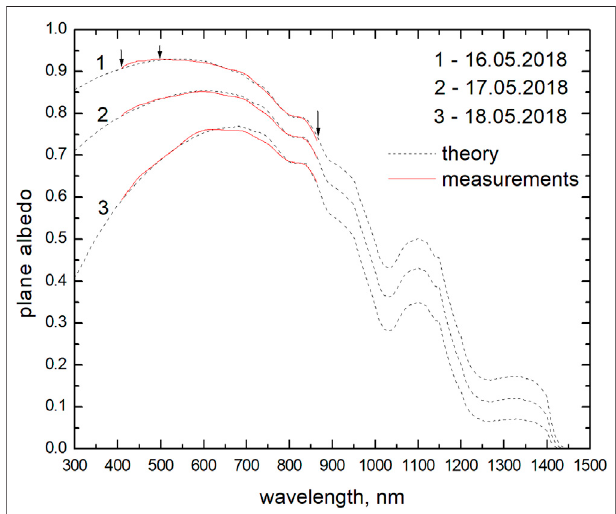
FIGURE 3 | The spectral snow albedo: measurements – solid lines, calculations using Eq. 36 – dashed lines. Dates refer to the acquisitions of the albedo spectra. Arrows show the wavelengths used in the inversion procedure (410, 500, and 865